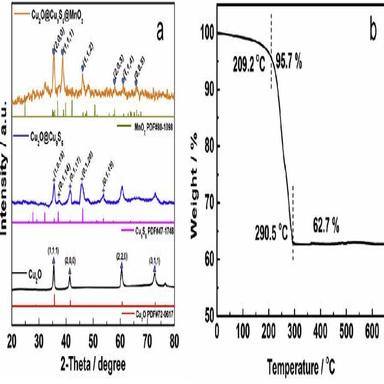
(a) XRD patterns of the Cu2O, Cu2O@Cu9S5 and Cu2O@Cu9S5@MnO2 samples; (b) TGA curves of the Cu2O@Cu9S5@MnO2 hollow spheres.